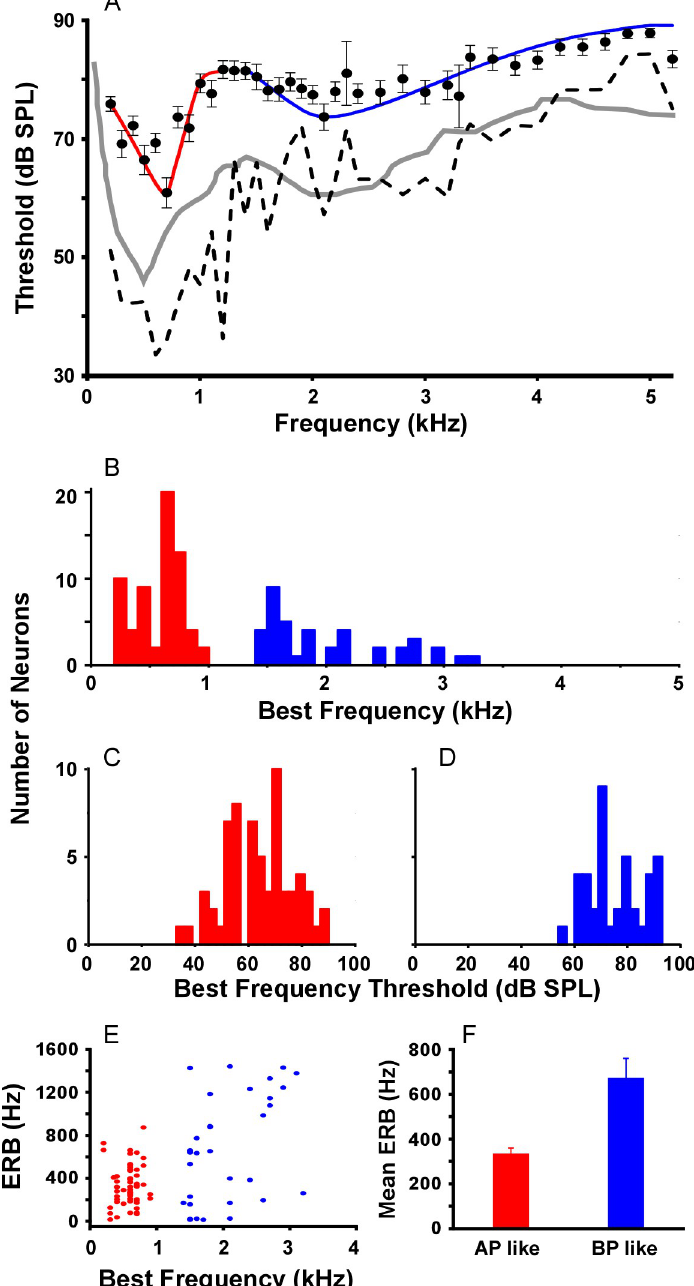
Fig 4. Summary of frequency sensitivity characteristics of cells. (A) Overall tuning from all recordings. Filled circles are the mean ( ± s.e.) threshold for each frequency. Red and blue curves are the least squares fits of the rounded exponential function to the mean thresholds for the low and high frequency channels (1.2 kHz boundary), respectively [69]. Dotted line shows the lowest threshold at each frequency across all cells. Grey curves are previous threshold data measured using multiunit recordings from large areas of the TS from Ryan et al. [69]. (B) Histogram showing the distribution best frequencies in the low and high frequency channels, revealing two distributions with no best frequencies from 1–1.4 kHz (histogram bin width = 100 Hz). (C-D) Histograms showing the distribution of best thresholds at frequencies below and above 1.2 kHz (blue and red, respectively). (E) Relationship between best frequency and equivalent rectangular bandwidth (ERB) size. Red and blue are ERBs centered at best frequencies below and above 1.2 kHz, respectively. (F) Mean ( ± s.e.) ERB size in the low and high frequency bands (amphibian papilla, AP and basilar papilla,